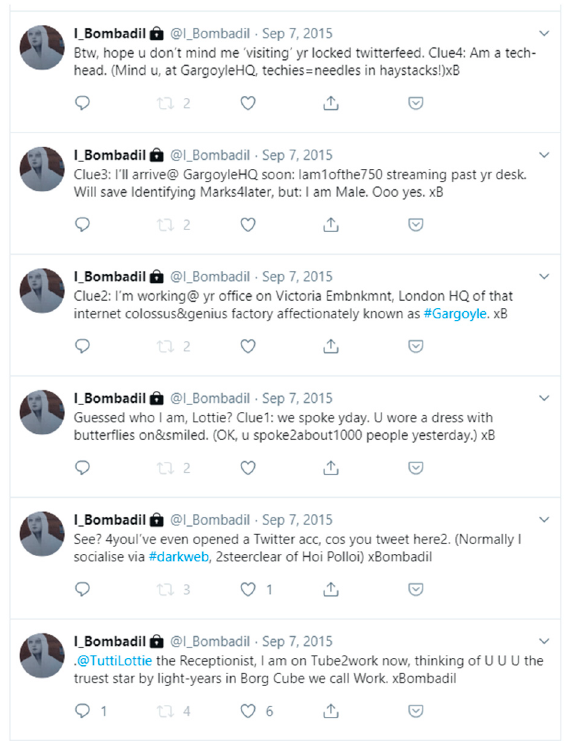
Figure 1. @I_Bombadil’s first six tweets.